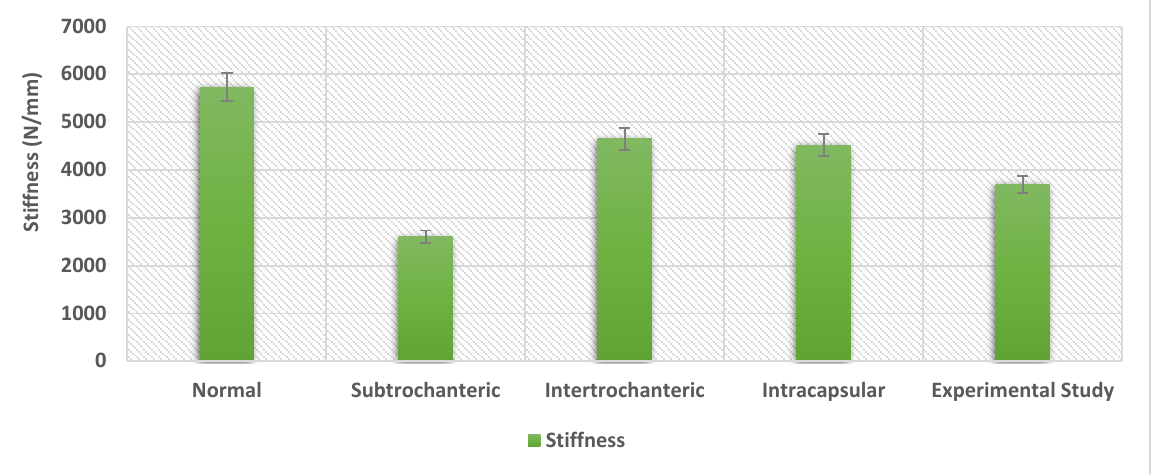
Figure 17. The stiffness for the experimental work performed by Hamandi et al [34] versus the computational finite element simulations results under the torsion scenario.